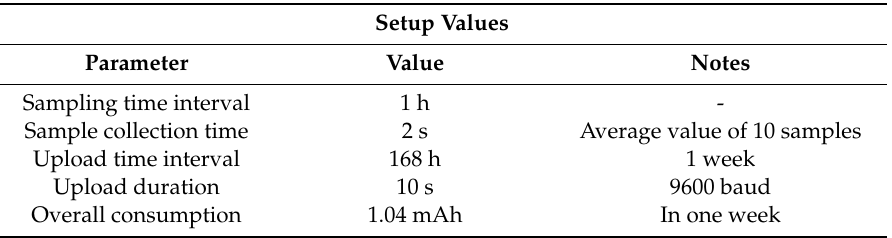
Table 3. An example of working conditions of AgriLogger sensor depending on the preferred settings to be applied.